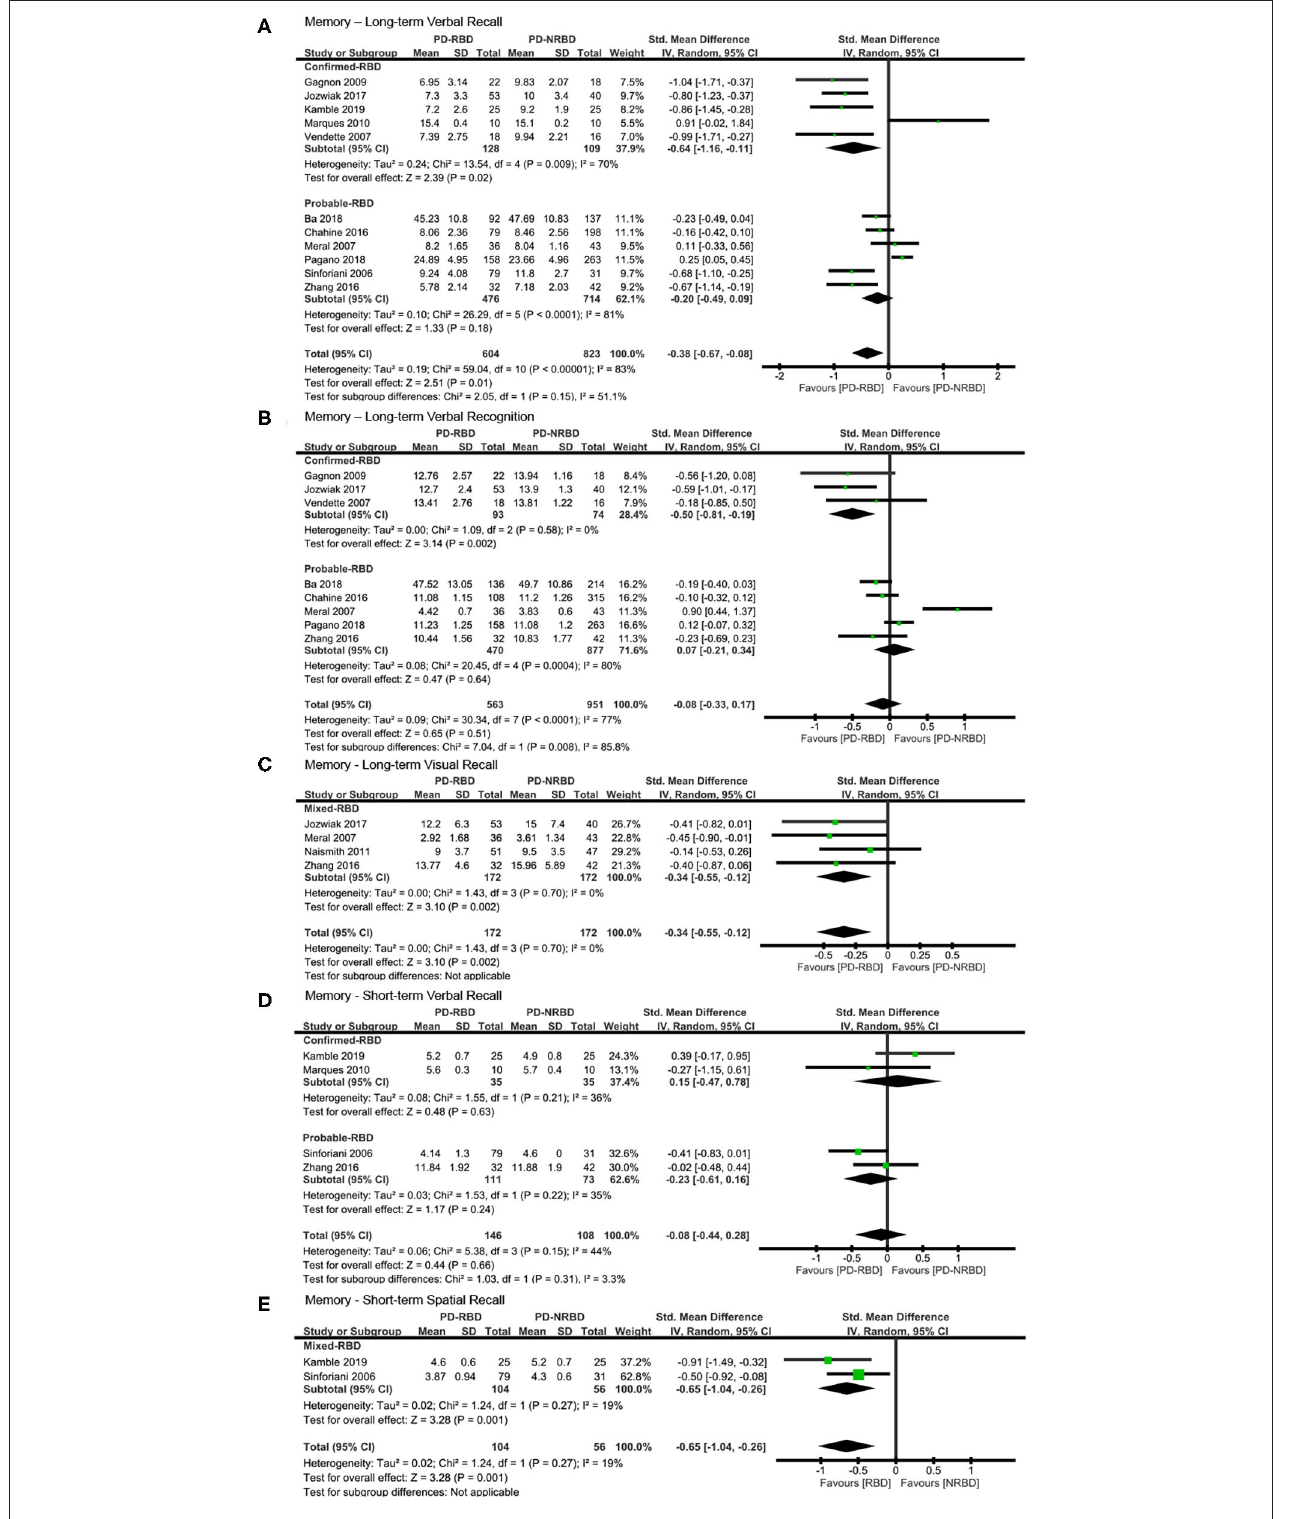
FIGURE 3 | Forest plot for (A) long-term verbal recall with subtotals by the diagnosis of rapid eye movement sleep behavior disorder (RBD), (B) long-term verbal recognition with subtotals by the diagnosis of RBD, (C) long-term visual recall, (D) short-term verbal recall with subtotals by the diagnosis of RBD, and (E) short-term spatial recall displaying effect size calculated using a random-effects model. SD, standard deviation; Std. Mean Difference , standardized mean difference; CI , confidence interval.